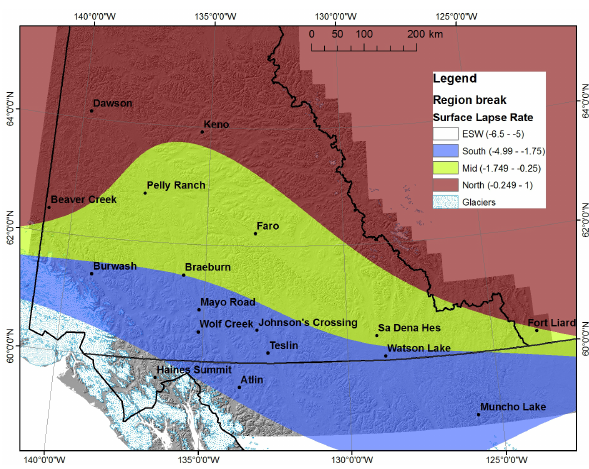
Fig. 8. Sub-regions based on common SLRs. Table 1. Percentage area underlain by permafrost in each scenario by sub-region.